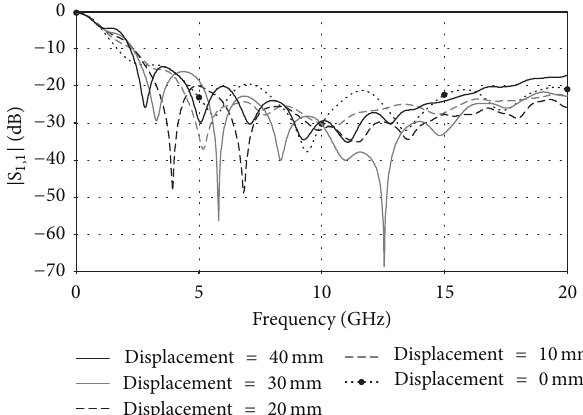
Figure6: Reflection coefficient magnitude ofa conical antenna with elliptical aperture displaced from 0 to 40 mm.